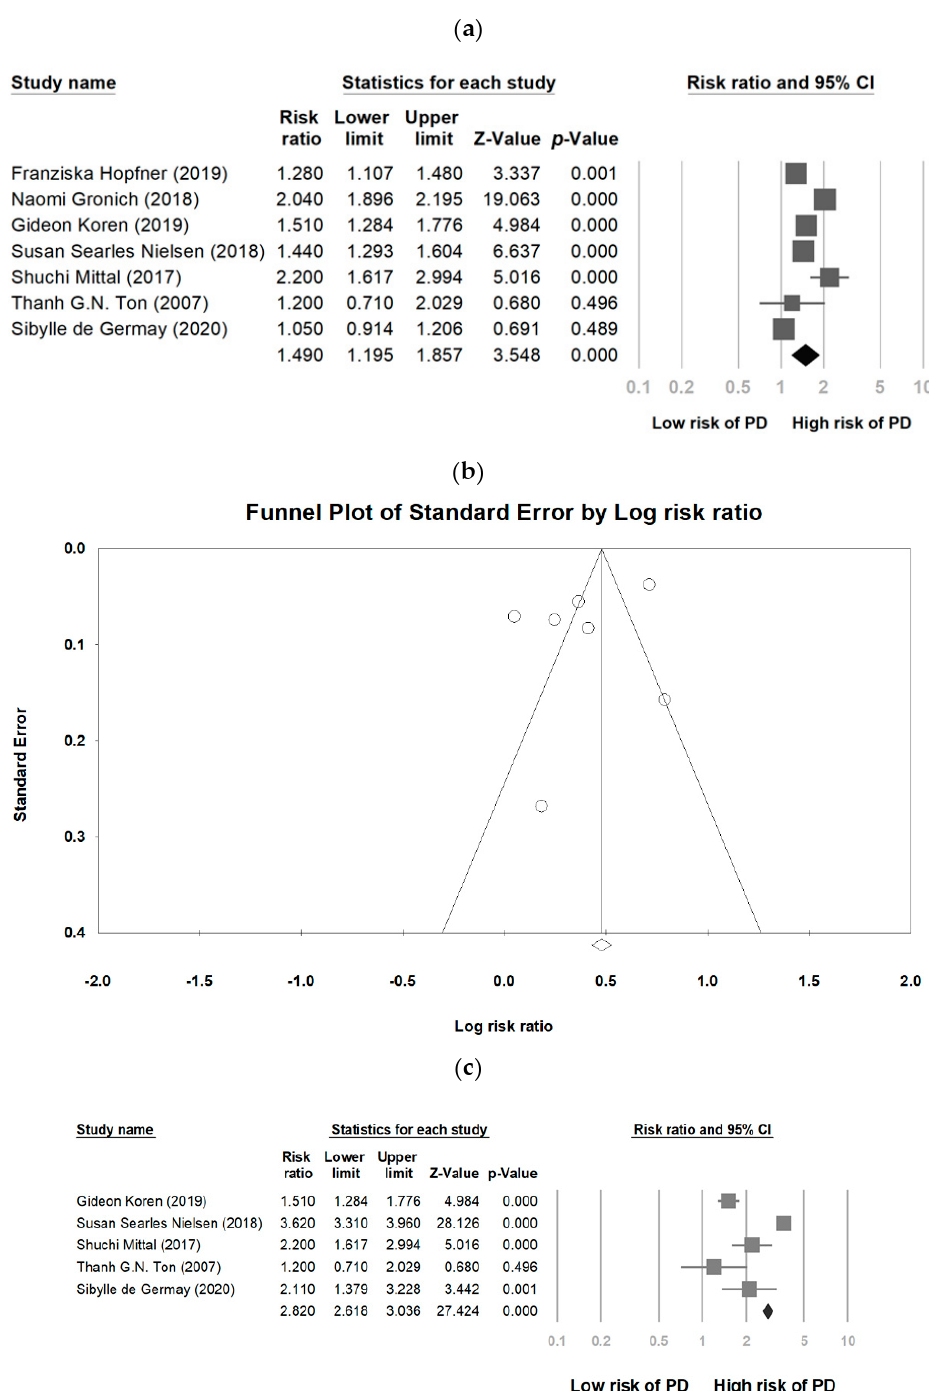
Figure 3. Forest plot of relations between β 2AR antagonist and PD risk ( a ), funnel plot analysis for publication bias ( b ), and forest plot of the risk of PD with propranolol exposure ( c ).